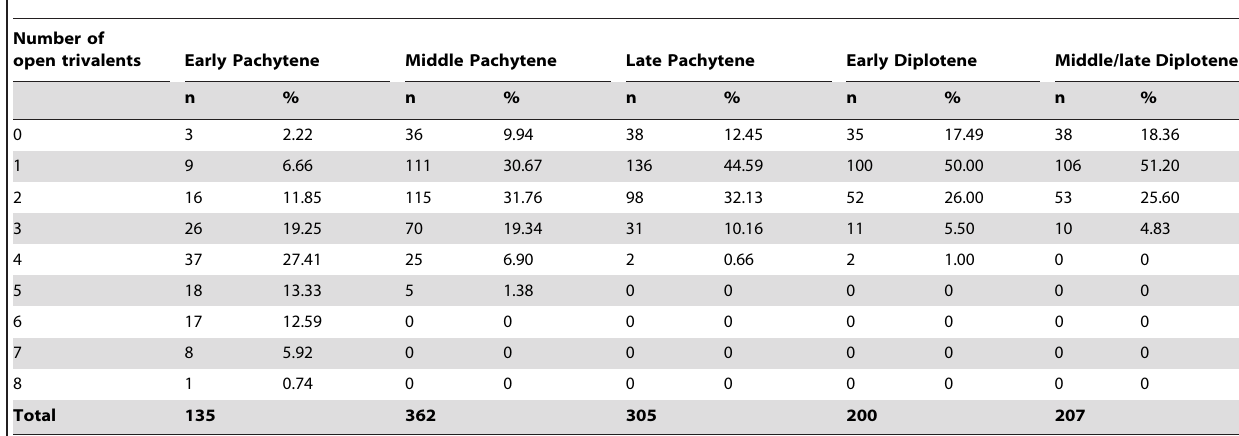
Table 1. Number and frequency of cells showing open trivalents during pachytene and diplotene in Robertsonian heterozygotes.